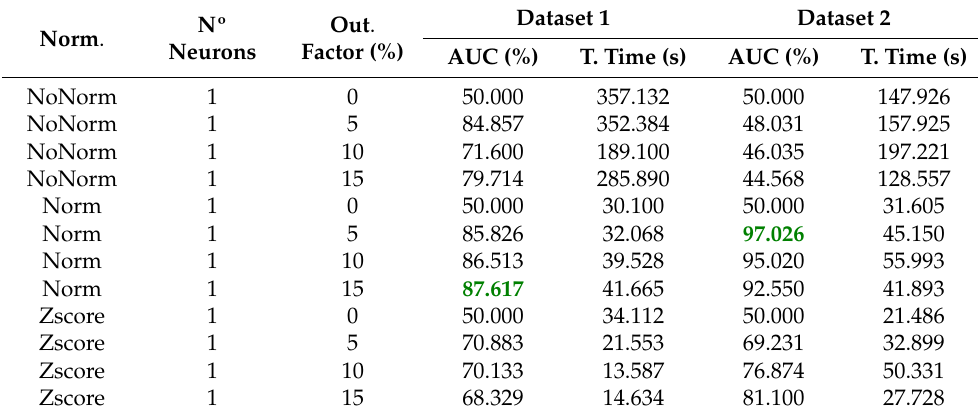
Table 6. Autoencoder results for dataset 1 and 2.